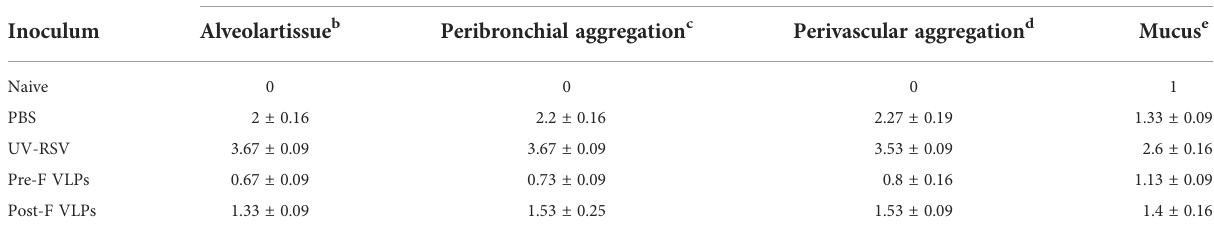
TABLE 2 Histopathological scores of lungs from immunized mice on Day 4 following RSV